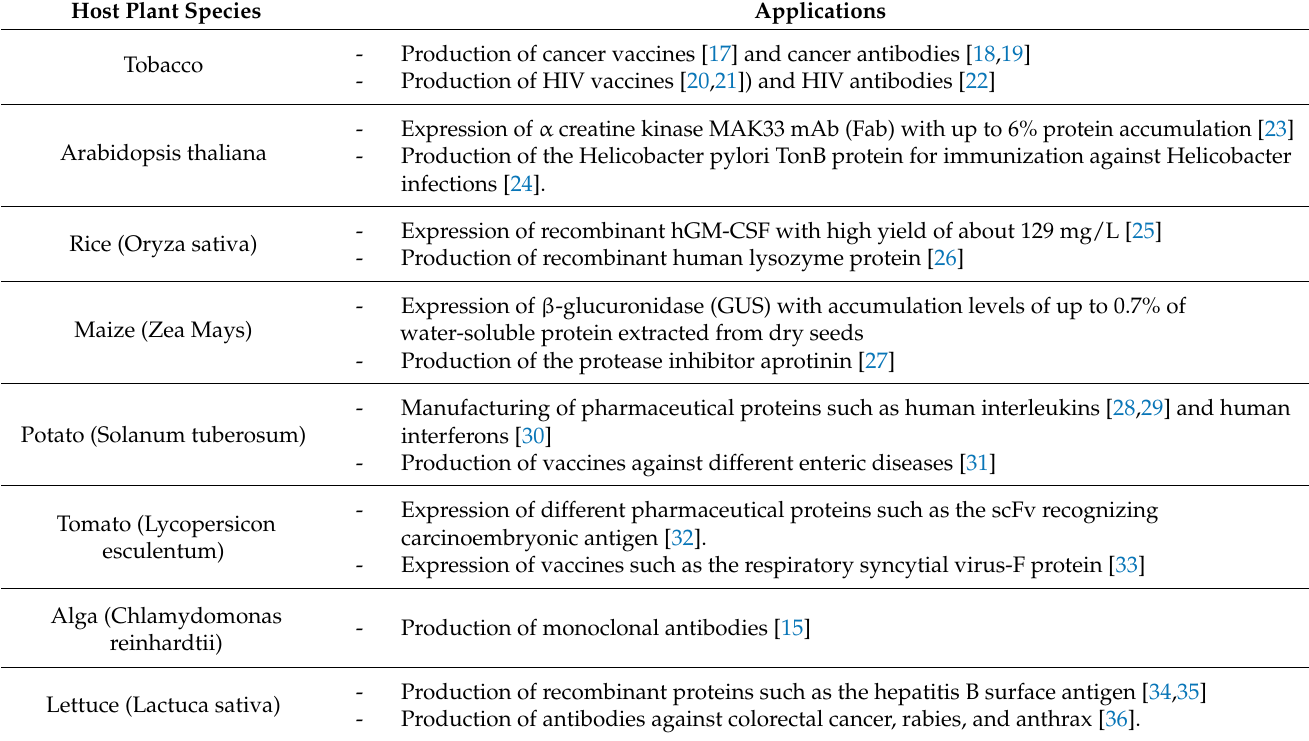
Table 1. Applications of different plant species in recombinant protein production.